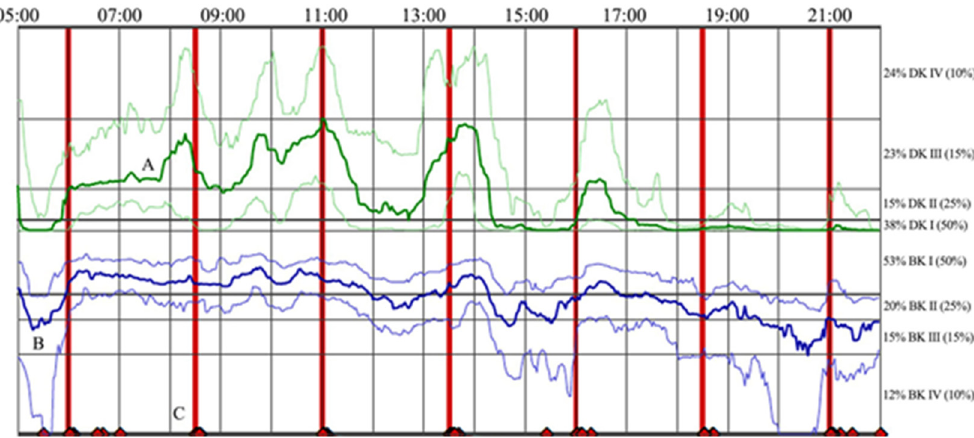
Figure 1. Sample PKG sensor time-series data [23], displaying an individual’s change in dyskinesia and bradykinesia scores in response to medication with the median, 25th, and 75th percentile, compared to a non-PD control group averaged over six days. ( A ) The dyskinesia time-series, ( B ) the bradykinesia time-series, and ( C ) the patient’s self-reported acknowledgment of medication administration.